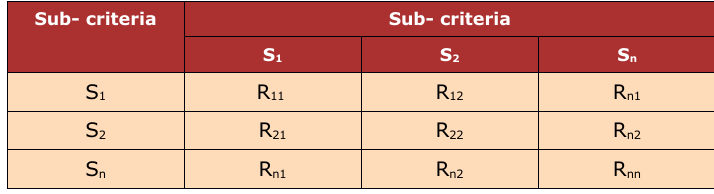
Table 5. Total- relation